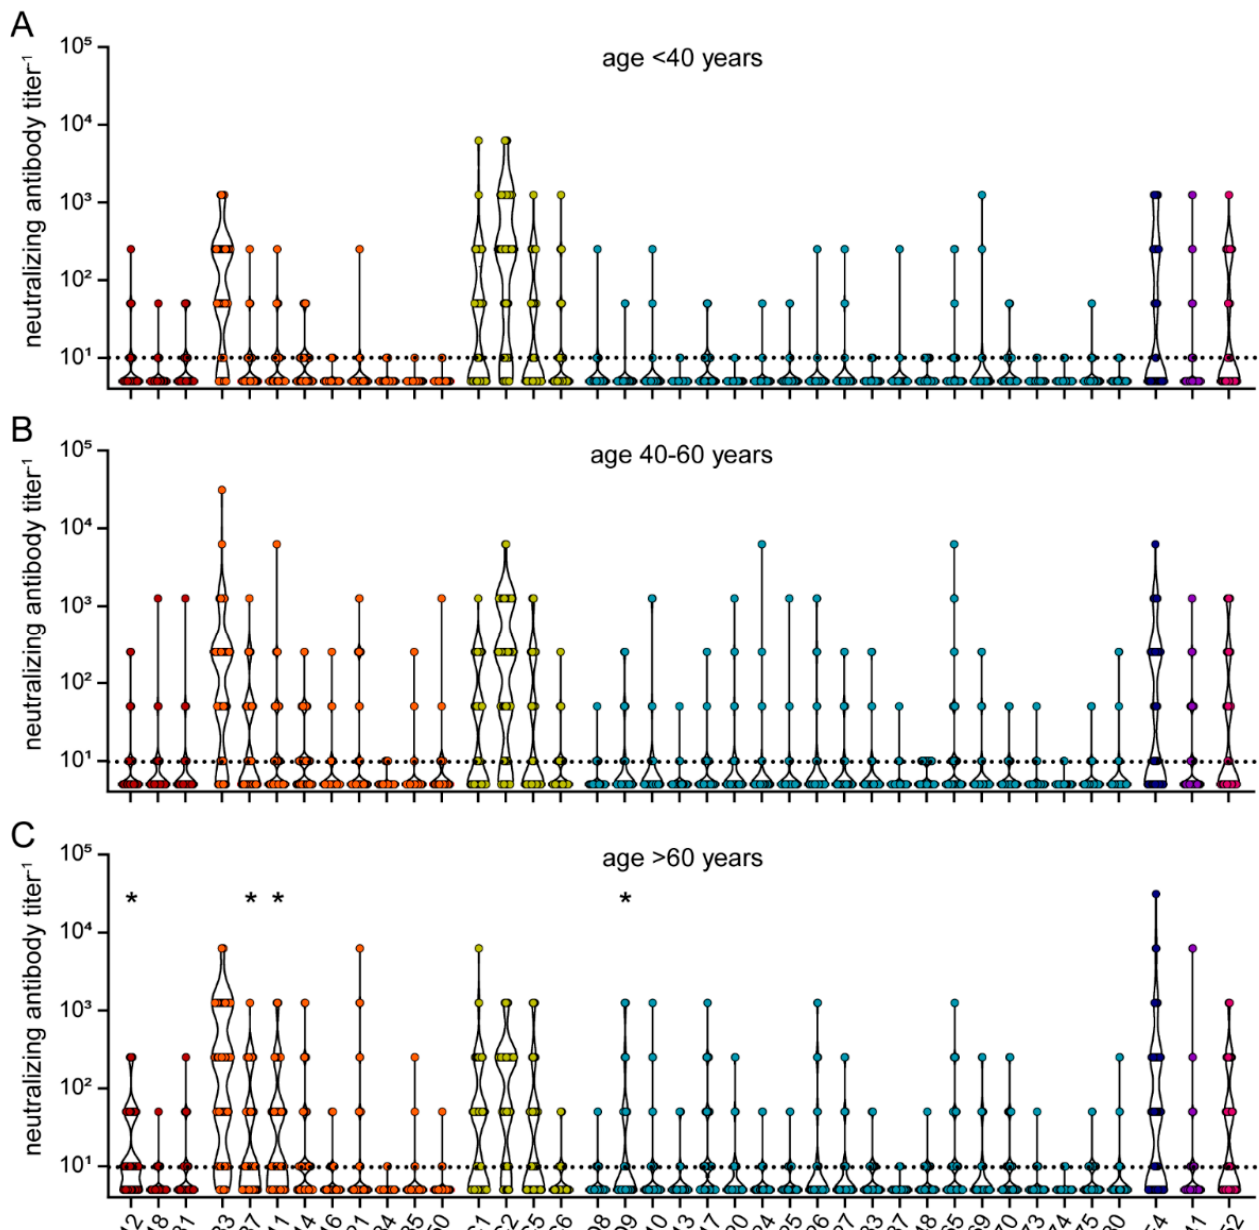
Figure 7. Neutralizing antibody data stratified by age of serum donors. The data presented in Figure 5 were stratified by the age of the serum donors and grouped as ( A ) below 40 years of age ( n = 49), ( B ) 40 to 60 years of age ( n = 84), and ( C ) older than 60 years ( n = 76). Each dot represents an individual sample. Significant differences in neutralizing antibody levels compared to the age group “< 40 years” are indicated by * ( p < 0.05, Kruskal-Wallis one-way ANOVA on ranks, Dunn´s multiple comparisons test).